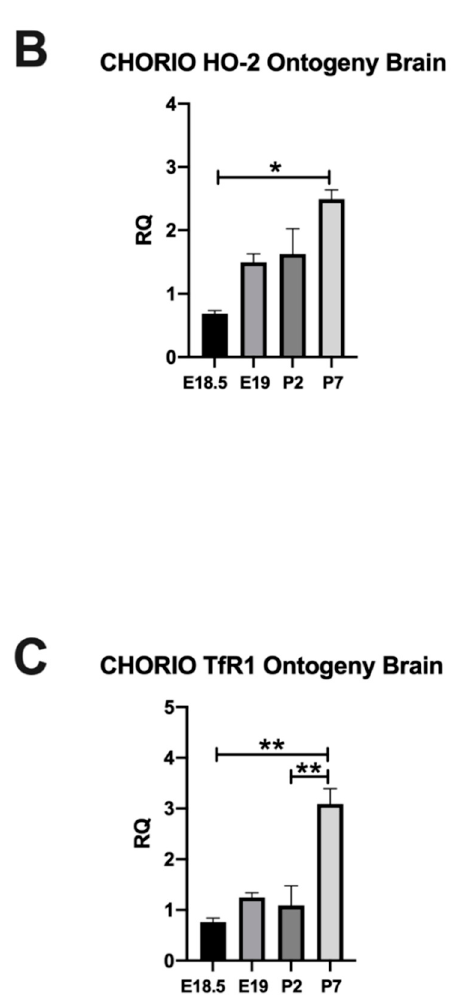
Figure 3. Ontogeny of HO-1, HO-2, and TfR1 in CHORIO. Effect of CHORIO on the developmental regulation of HO-1 (( A ), n = 8, 4, 3, 7, E18.5 vs. P7, ** p = 0.0028), HO-2 (( B ), n = 6, 3, 5, 7, P7 vs. E18.5, * p = 0.0011) and TfR1 (( C ), n = 7, 6, 6, 7, P7 vs. E18.5, ** p = 0.0022, P7 vs. P2, ** p = 0.005) is displayed at E18.5, E19, P2, and P7 respective postnatal ages. p significant when <0.05, Kruskal–Wallis test, mean ± SEM.